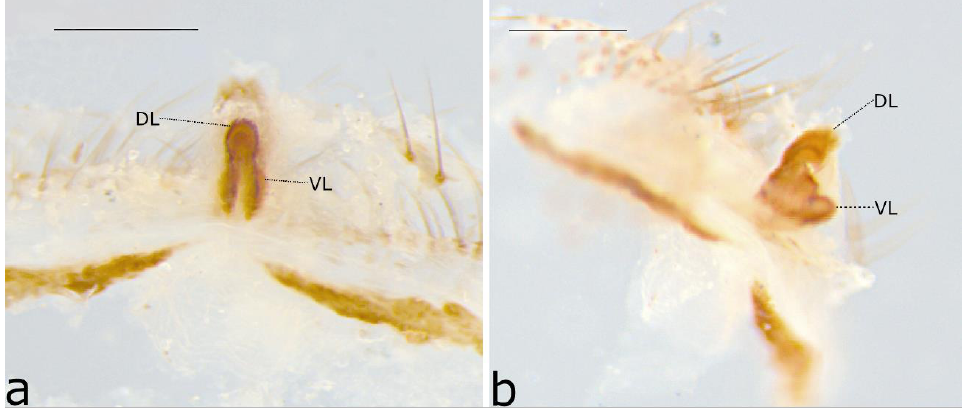
Figure 68. Ariadna ungua sp. nov. ♀ paratype (SAMA NN30473) from Lake Dam, near Lake Frome/Munda (SA): anterior receptaculum ( a ) ventral view; ( b ) same, lateral view. Scale bar = 0.2 mm. DL = dorsal lobe, VL = ventral lobe.